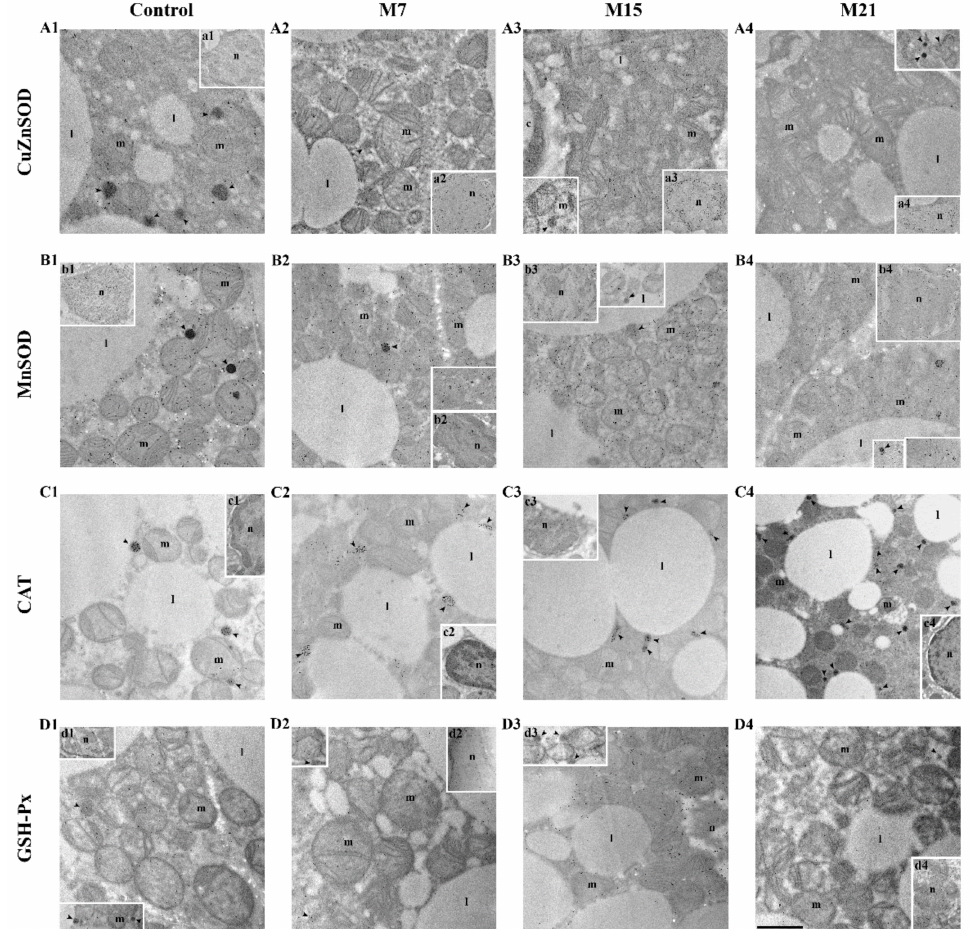
Figure 3. Immunogold labeling of CuZnSOD ( A1 – A4 ); MnSOD ( B1 – B4 ); CAT ( C1 – C4 ); and GSH-Px ( D1 – D4 ) in rat brown adipose tissue of the control and hypothyroid groups treated with methima- zole for 7 (M7), 15 (M15), and 21 (M21) days, respectively. Insets, nuclear immunopositivity on CuZnSOD (a1-4), MnSOD (b1-4), CAT (c1-4), GSH-Px (d1, 2, 4); peroxisomal and mitochondrial immunopositivity (d3). l, lipid body; m, mitochondria; n, nuclei; arrowhead, peroxisomes. Scale bars 1 µ m. Abbreviations: CuZn- and Mn-superoxide dismutase (CuZnSOD and MnSOD, respectively), catalase (CAT), glutathione peroxidase